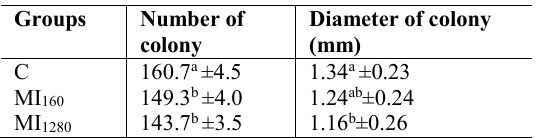
Table 3. Number and colony diameter (mm) of BMSCs after 7 days of treatment with MI.